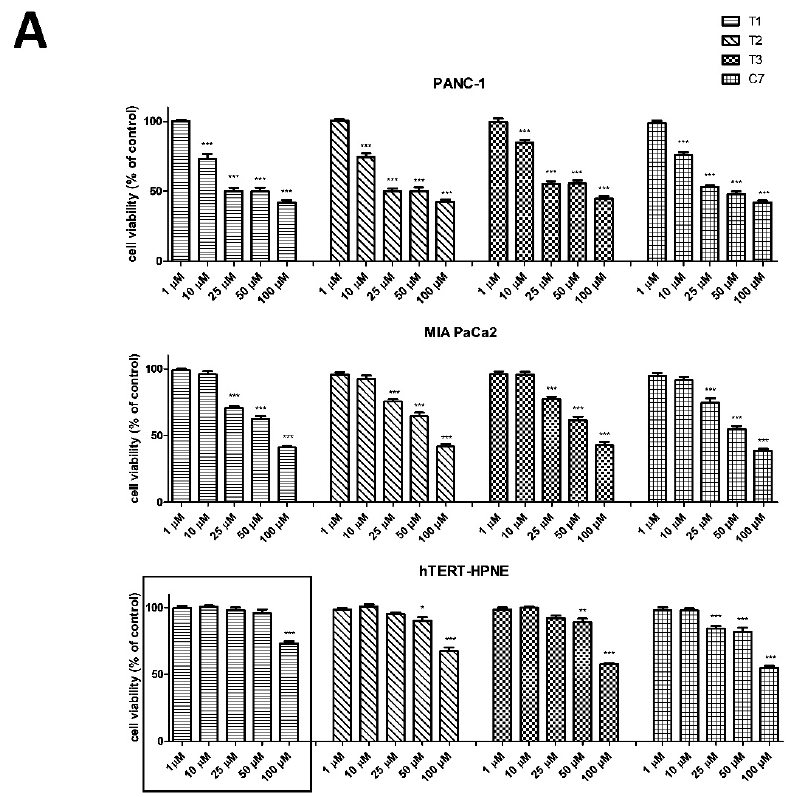
Table 1. Logarithms of the stability constant values (log β pqr ) of the VO(IV) complexes obtained by adapting the equilibrium model to PT data. The corresponding standard deviations are given in